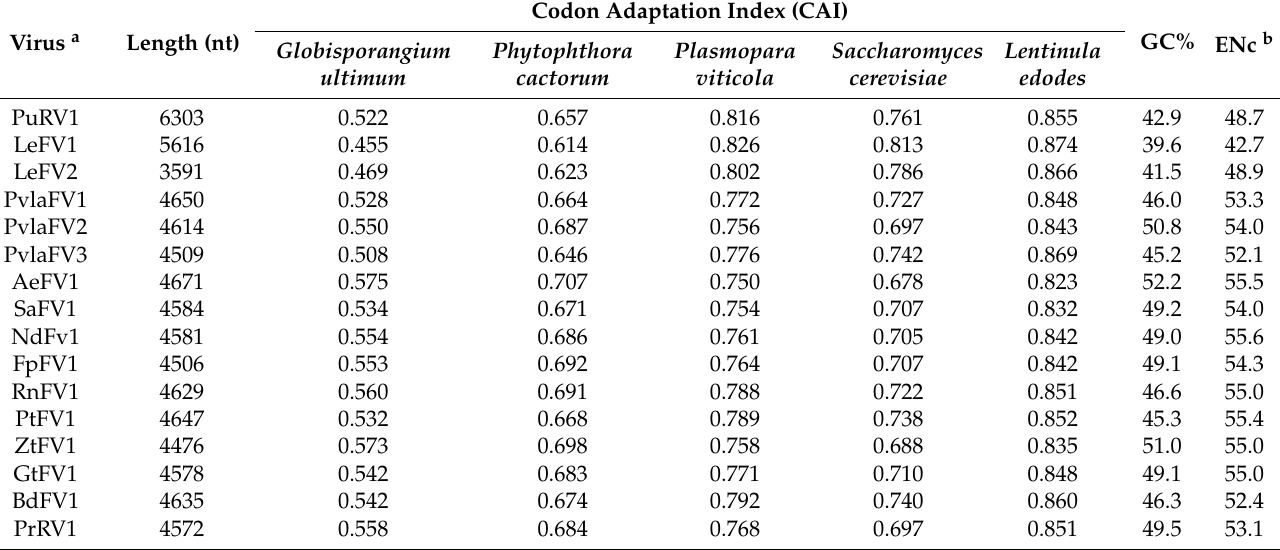
Table 3. Codon Adaptation Index (CAI), GC contents (GC%), and Effective Number of Codons (ENc) of the RdRp gene of